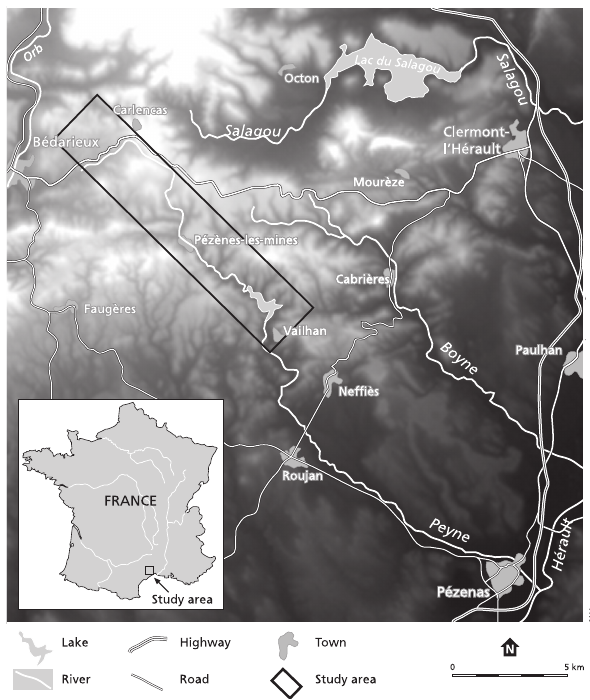
Fig. 2. Location of the study area in Southern